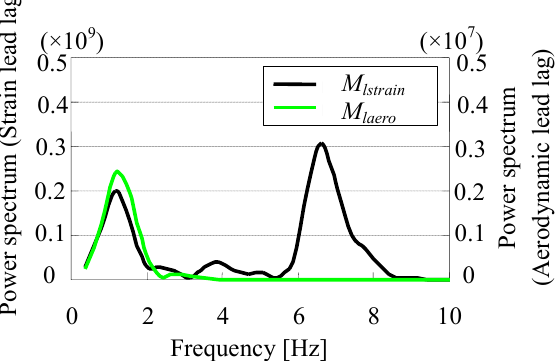
Figure 6(d). Power spectrum of lead lag